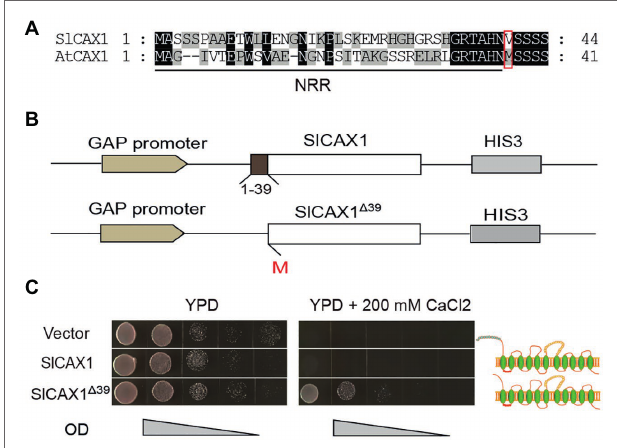
FIGURE 2 | Truncating the first 39 amino acid residues of SlCAX1 increased the Ca 2+ transport ability. (A) Partial amino acid sequence alignment of the N-terminal region of CAX1 from Arabidopsis and tomato. Consensus amino acid residues are boxed in black (identical) or grey (similar). Gaps introduced to maximize the alignments are denoted by hyphens. The red box indicates the 2nd methionine of AtCAX1 and the analogous valine of SlCAX1. (B) Schematic of SlCAX1 and SlCAX1 Δ 39 expression vectors in yeast. The first 39 amino acids of SlCAX1 were truncated, and the 40 th amino acid, valine, was mutated to methionine, resulting in SlCAX1 Δ 39 . HIS3 indicates that yeast containing this construct were able to grow on medium lacking histidine. (C) SlCAX1 and SlCAX1 Δ 39 were expressed in the yeast strain K667. The cultures were diluted 10, 100, 1,000, and 10,000 times from OD 1.0, respectively, and an equal amount was pipetted onto yeast YPD medium with or without 200 mM CaCl 2 . The yeast cells were cultured for 3 days at 30 °